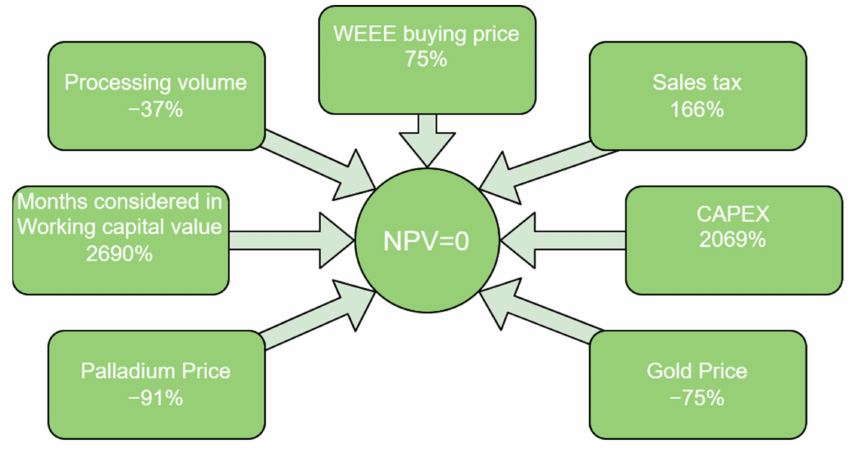
Figure 7. Sensitivity Analysis to reset the NPV of Case A.